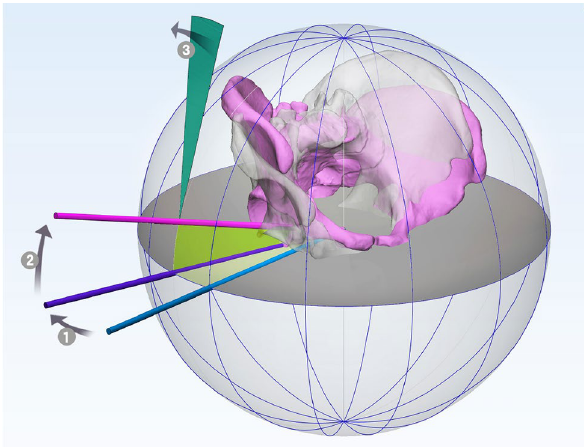
Figure 3. Pelvic orientation described according to the globographic coordinate system. The sequence of rotation (1), obliquity (2), and flexion (3) agrees with conventional clinical understanding 42,43 . The transparent and grey pelvis indicate the neutral position, while the opaque and pink pelvis indicate the position with − 15° rotation, + 15° obliquity, − 15° flexion from neutral position (the direction of +/− is described in the text). MIMICS 20.0 (Materialise, Leuven, Belgium) and 3-matic 12 (Materialise) were used to create the